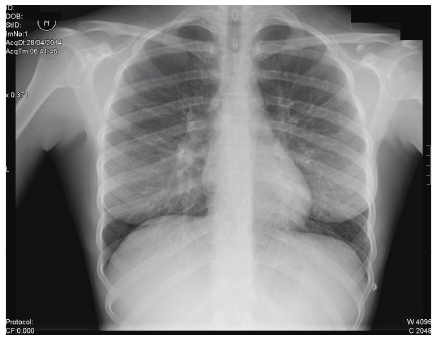
Figure 1: Erect chest radiograph on admission.